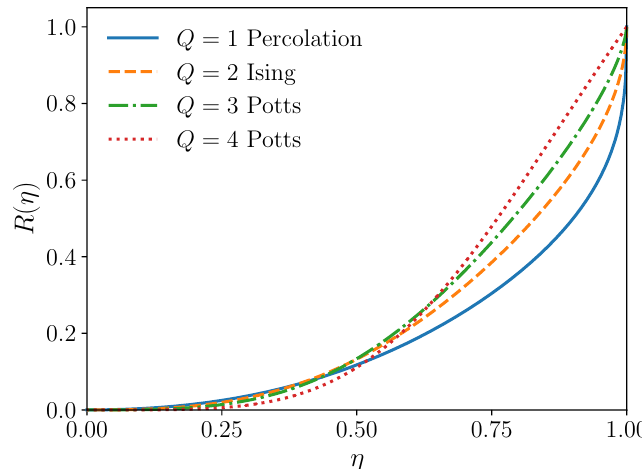
Figure 4 . The universal ratio R in eq. (2.3) in the critical Q -color Potts model as a function of the anharmonic ratio (cid:17)